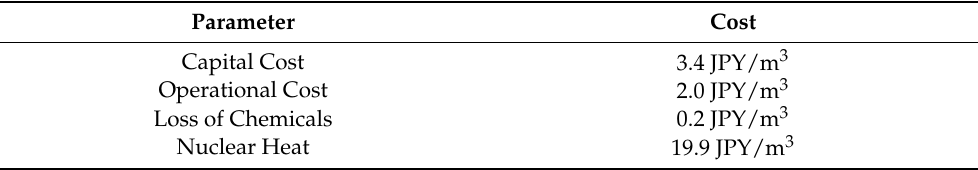
the capital cost is taken on a capacity basis (i.e., Nm 3 of capacity). The table uses data from [18]. Parameter Cost